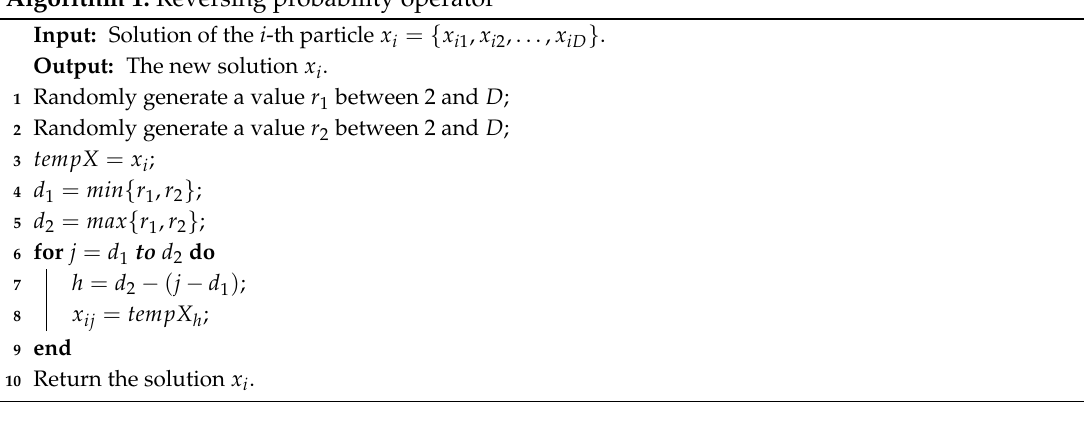
Algorithm 1: Reversing probability operator